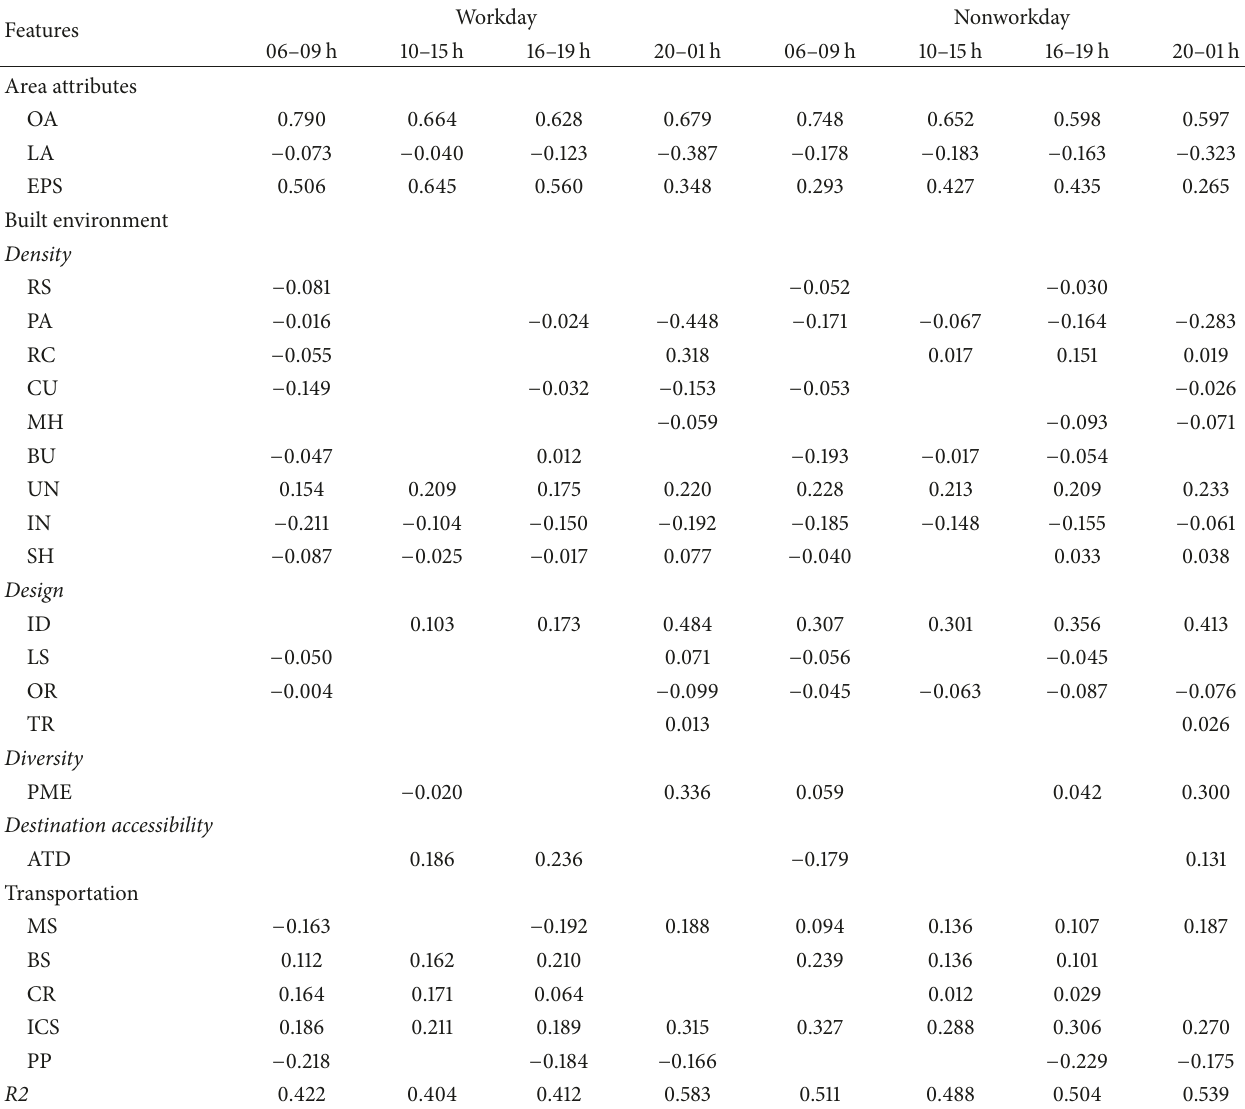
Table 3: The result of monthly usage intensity